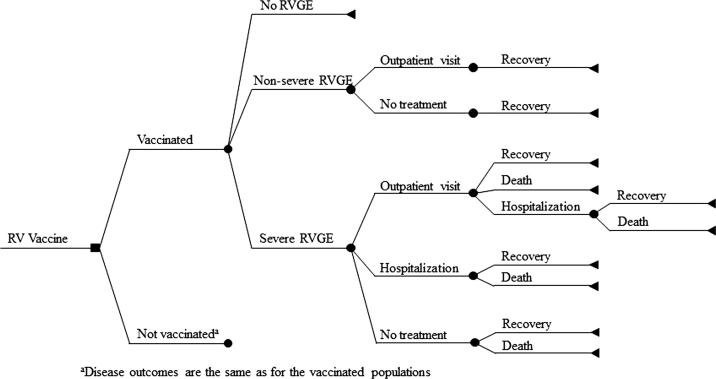
Model schematic.